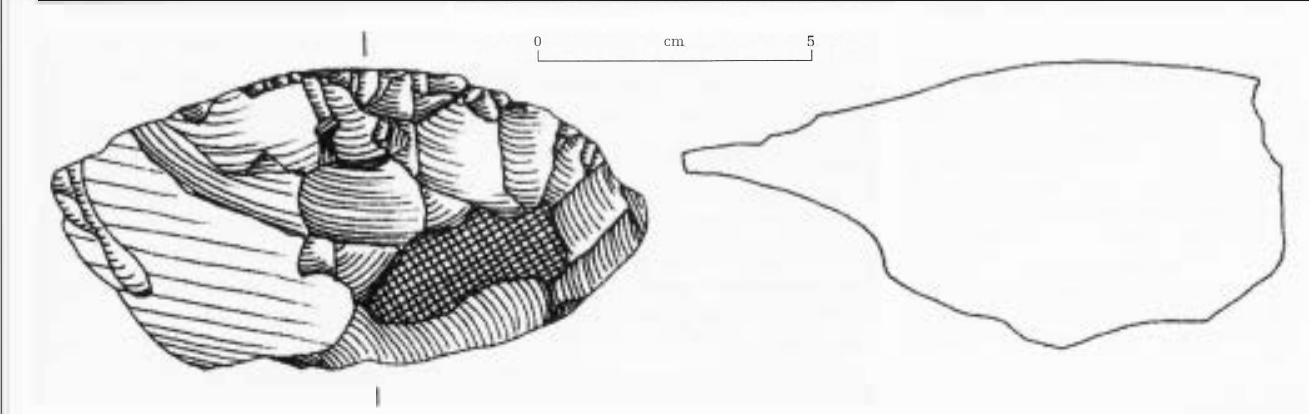
Figure 4 A beginner's core, Klein Auheim {drawn by Ulrike So mm er and Birgit